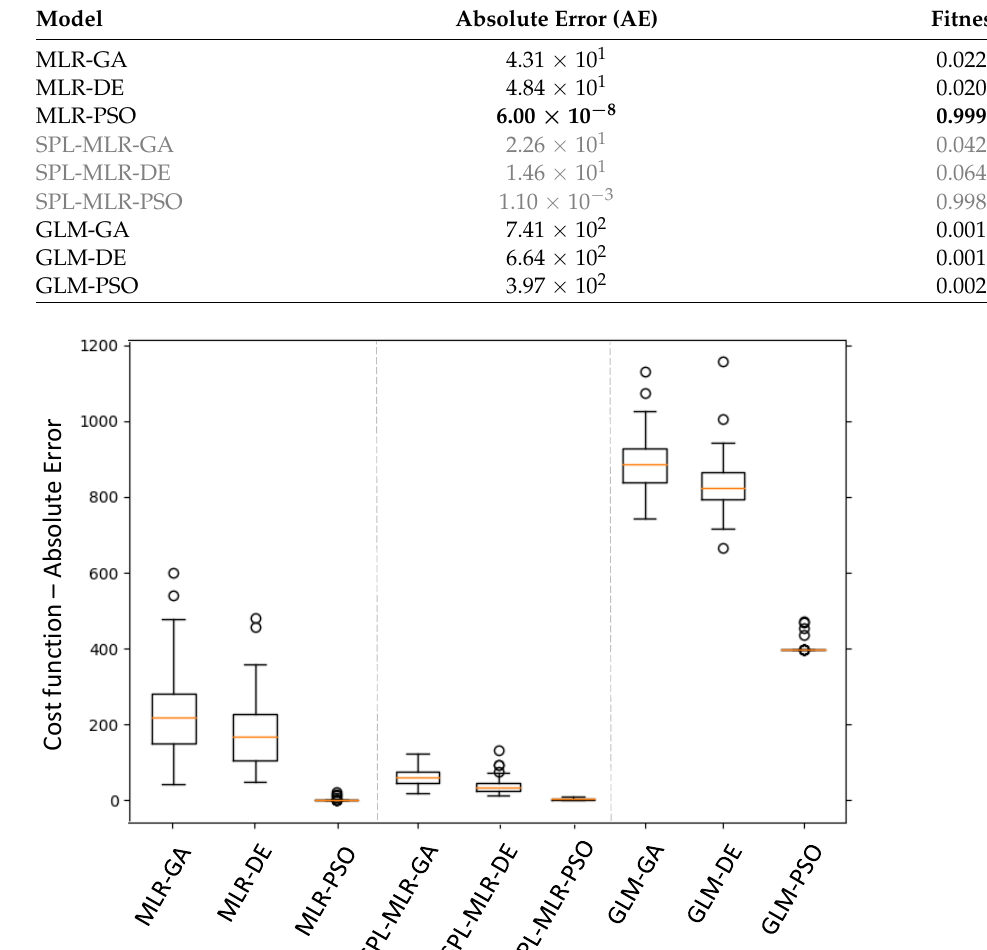
Table 2. Results obtained from the optimization performed for the training algorithms.